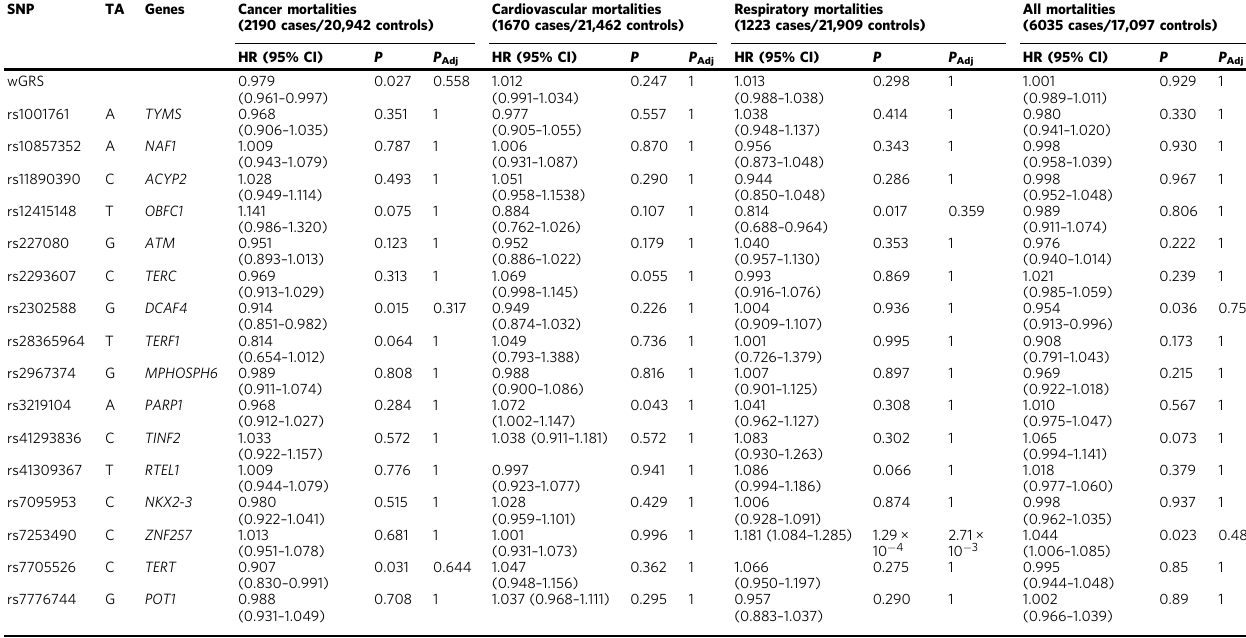
Table 4 Association of LTL reducing SNPs and weighted gene-risk score with mortalities in the SCHS SNP TA Genes Cancer mortalities Cardiovascular mortalities Respiratory mortalities (2190 cases/20,942 controls) (1670 cases/21,462 controls) (1223 cases/21,909